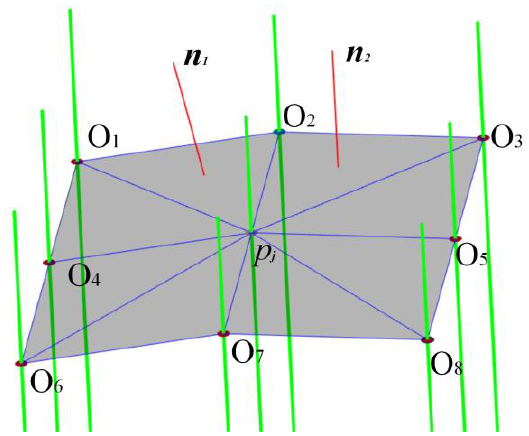
Figure 5. Normal Direction Solution of the Local Plane.